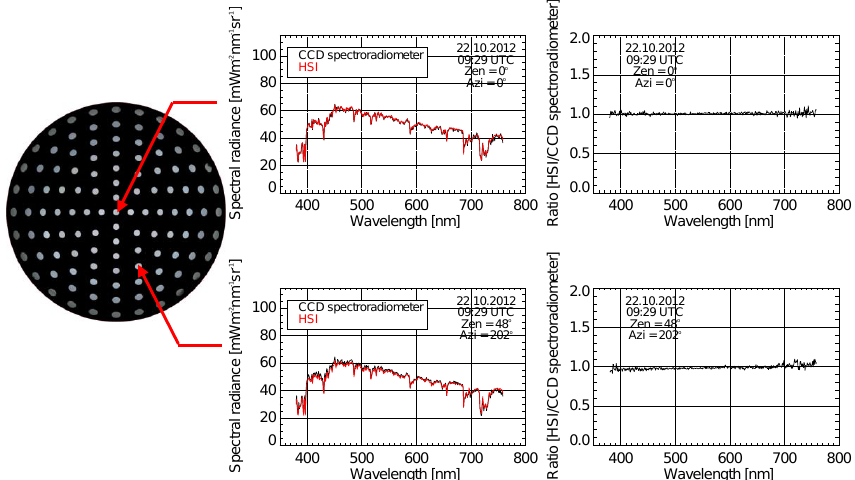
Figure 8. Spectral radiance on 22 October 2012 at 09:29UTC measured by the CCD spectroradiometer and the HSI system at the zenith (upper panel) and for azimuth angle of 202 ◦ , zenith angle of 48 ◦ (lower panel). The ratio between the measured and computed spectral radiance is shown on the